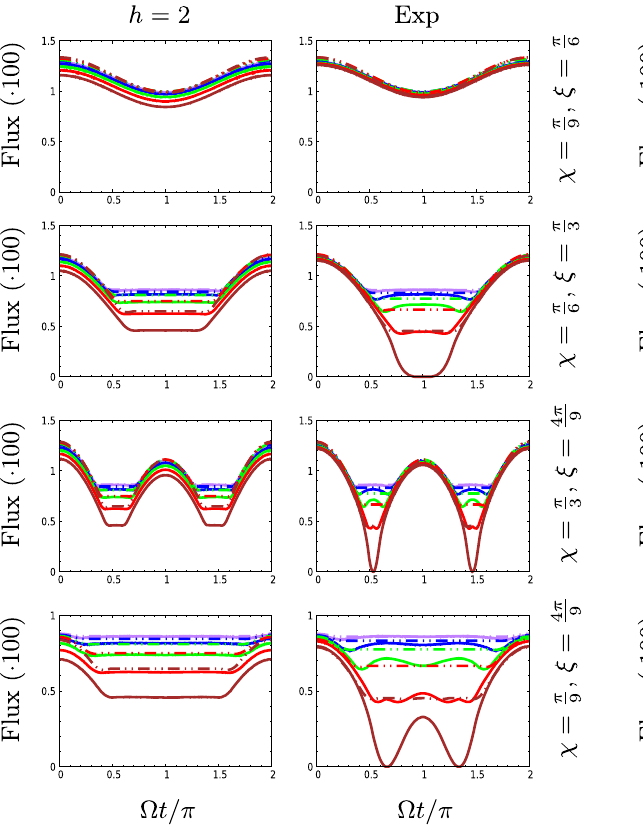
Fig. 34 Analytical pulse profile for two identical, antipodal caps. Schwarzschild, R = 6 M , q ∗ = − ( 0 . 50 M ) 2 , θ c = 5 o . Purple, blue, green, green, red and brown lines correspond to (cid:11) = 0 . 1, 0 . 2, 0 . 3, 0 . 4 and 0 . 5 respectively. The solid lines correspond to the numerical result, while the dashed lines correspond to the analytical approximation